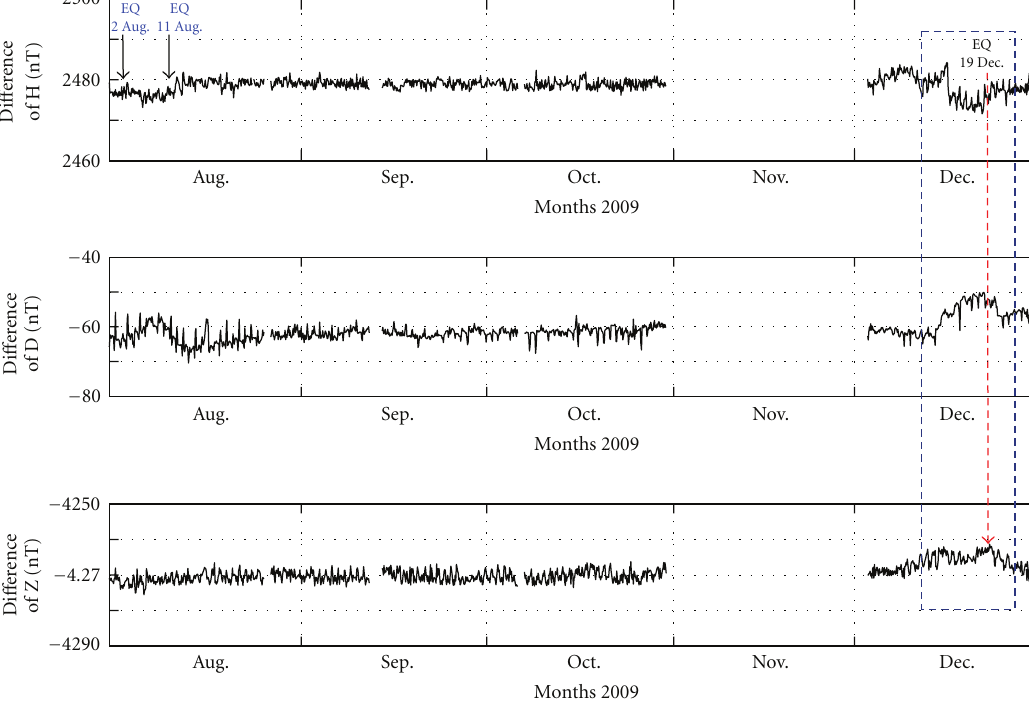
Figure 5: The di ff erences between the hourly averaged values of the H-, D-, and Z-components recorded at the HLN and AMA stations between August and December 2009 during nighttime (1100–2100